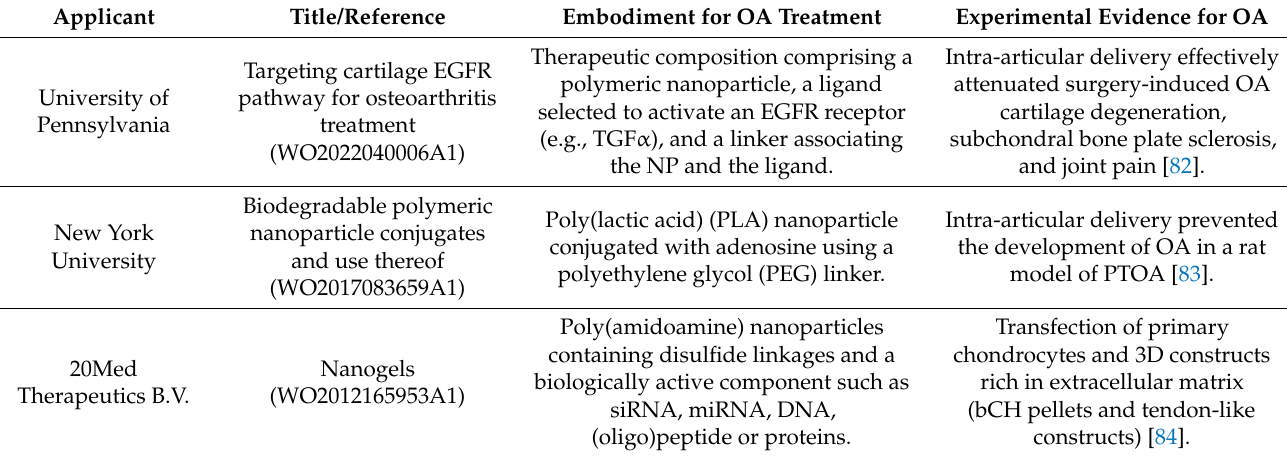
Table 3. Recent patents granted on polymeric nanoparticles and OA (last seven